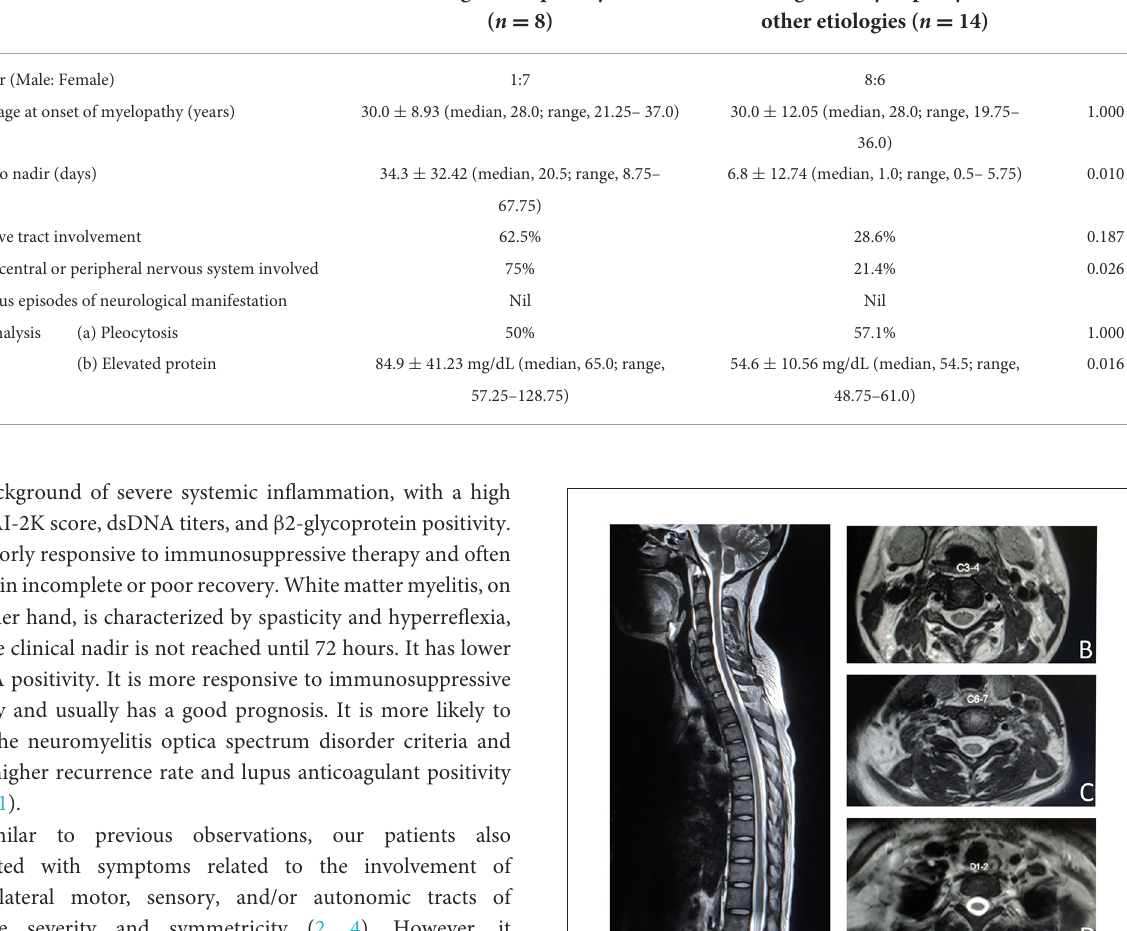
TABLE 3 Comparison of baseline clinical and biochemical features between MRI-negative lupus myelitis and MRI-negative myelopathy due to other etiologies. Parameters MRI-negative lupus myelitis